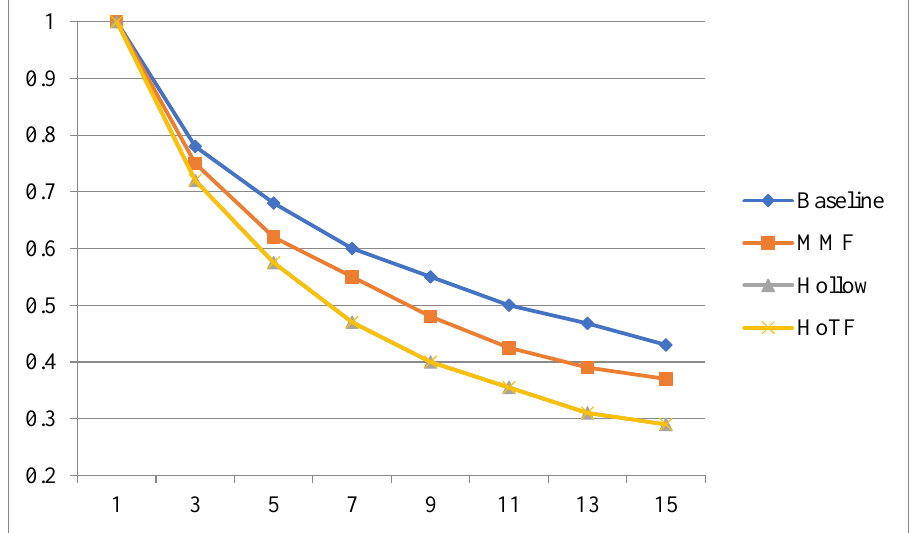
Figure 9. The recall rate of each feature representation method.